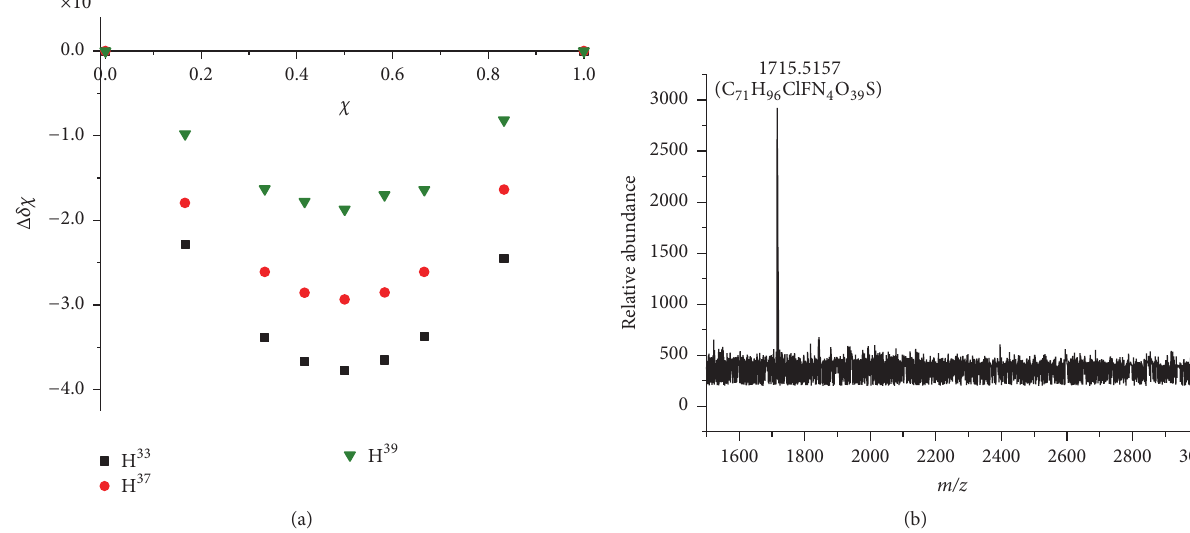
Figure 4: Determination of LAP- 𝛽 -CD stoichiometry. (a) Representative Job plot diagrams of selected LAP protons. (b) Representative mass spectrum of a LAP- 𝛽 -CD sample.